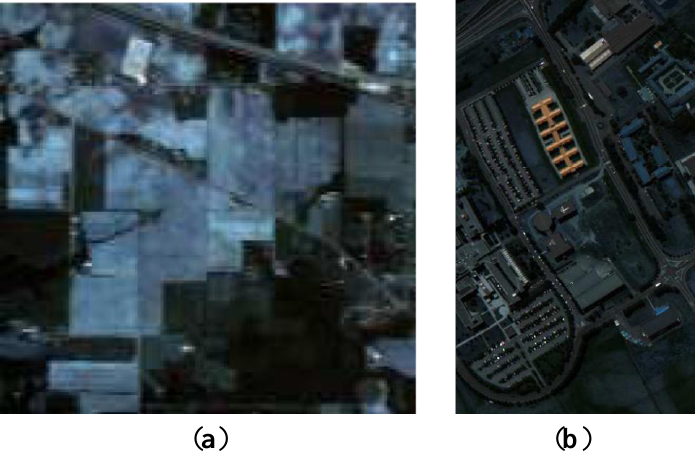
Number of Samples